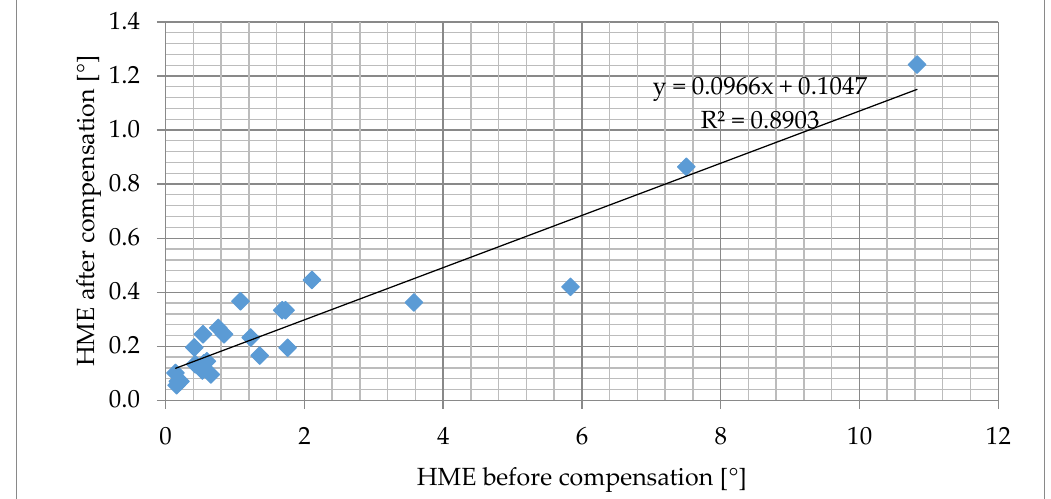
Figure 9. The efficiency of the compensation algorithm was tested on 10 different types of AMR sensors by comparing the indicator HME before and after compensation. The hysteresis before the compensation depends mostly on the sensing distance and on the method of construction.